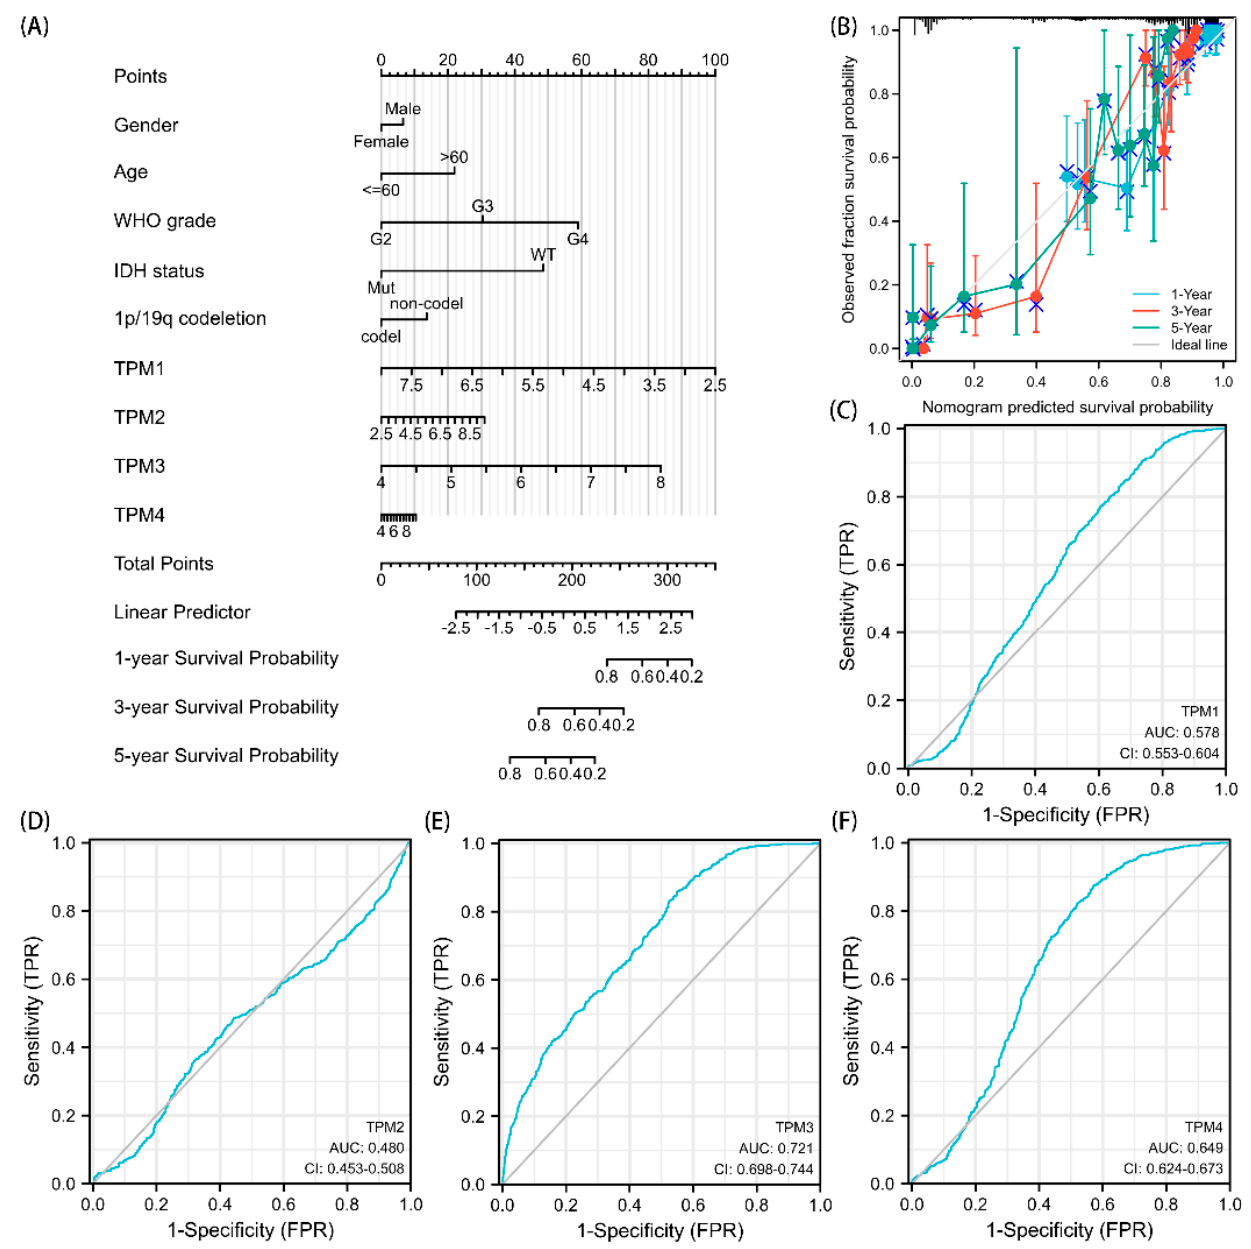
Figure 6. Diagnostic value of TPMs in glioma. ( A ) The nomogram was developed by integrating the TPM expressions with key clinical characteristics. ( B ) The calibration plot of the nomogram for predicting overall survival at 1 year, 3 years, and 5 years. ( C ) The diagnostic value of TPM1 mRNA expression was evaluated using a ROC curve. ( D ) The diagnostic value of TPM2. ( E ) The diagnostic value of TPM3. ( F ) The diagnostic value of TPM4.